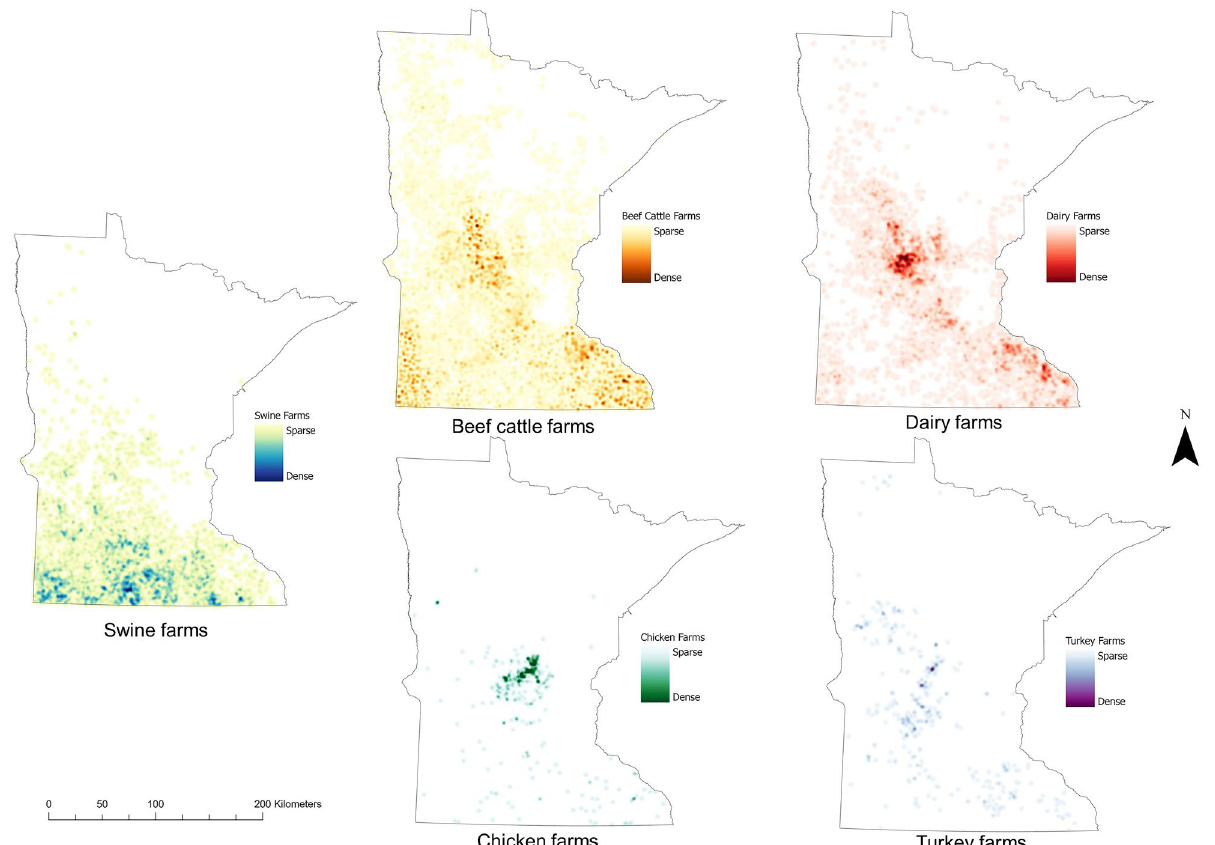
Figure 2. Heat maps of farm density for the different livestock species in